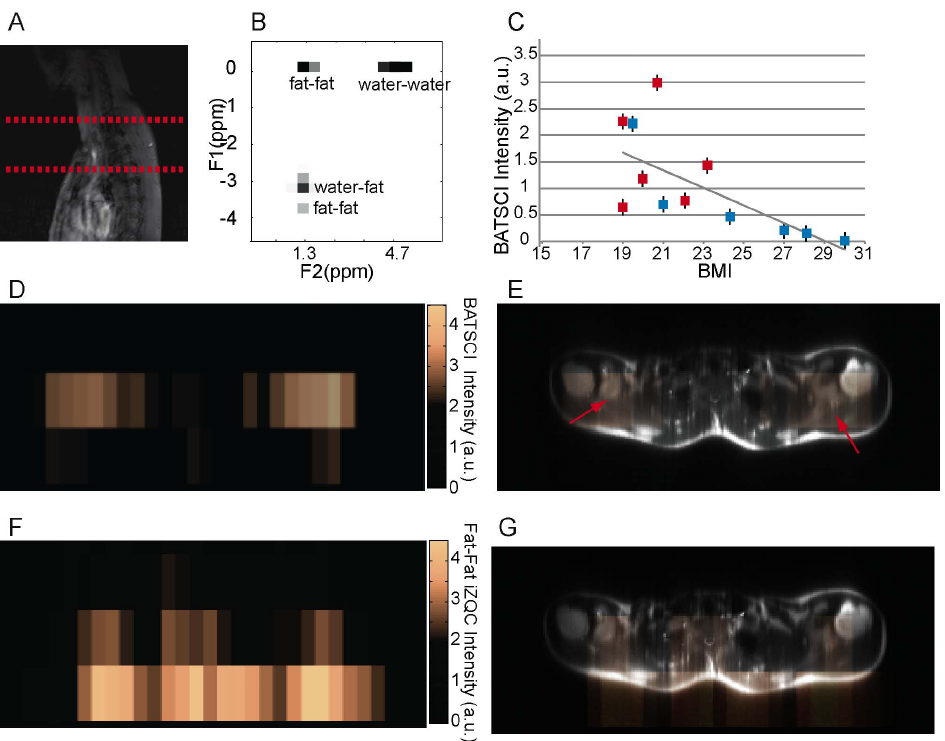
Figure 9. In vivo detection of human BAT in a lean subject. ( A ) 2D anatomical image showing the selected slice from which iZQC spectra and images were acquired. ( B ) 2D iZQC spectrum acquired from the neck-supraclavicular area of a young female with a BMI of 19. ( C ) Scatter plot showing the inverse correlation between subject BMI and normalized BATSCI signal intensity (r-value=66%, r-square=43%, p value less than 0.015). Blue solid squares indicate male subjects, while red solid squares indicate female subjects. ( D ) BATSCI map on the same subject. ( E ) Overlay of BATSCI on spin-echo axial image with red arrows indicating possible BAT locations. ( F ) Fat-fat iZQC map on the same subject. ( G ) Overlay of fat –fat iZQC map on spin-echo axial